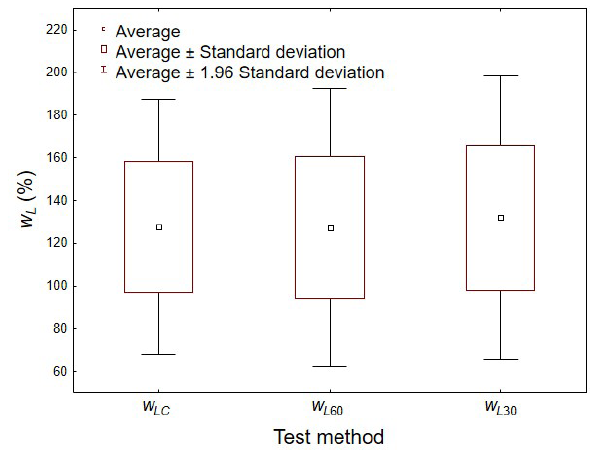
depending on the test L